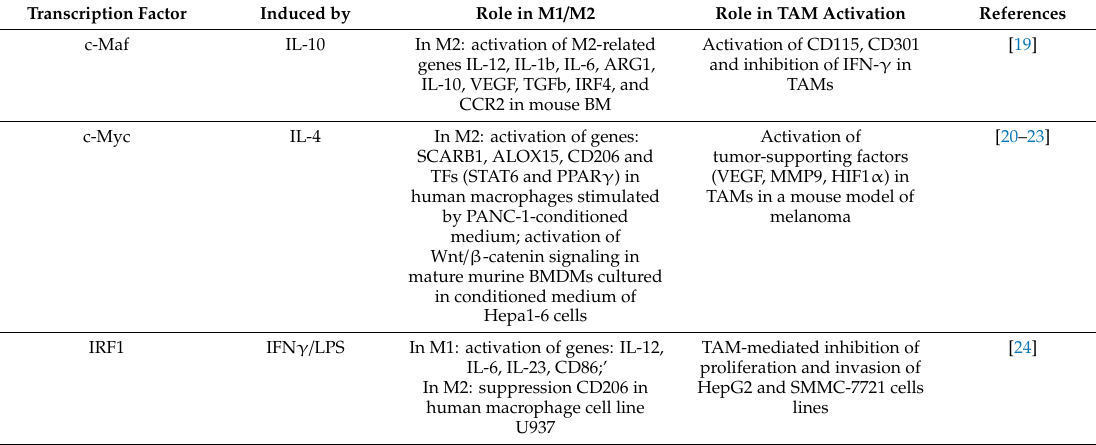
Table 1. The role of transcription factors in macrophage